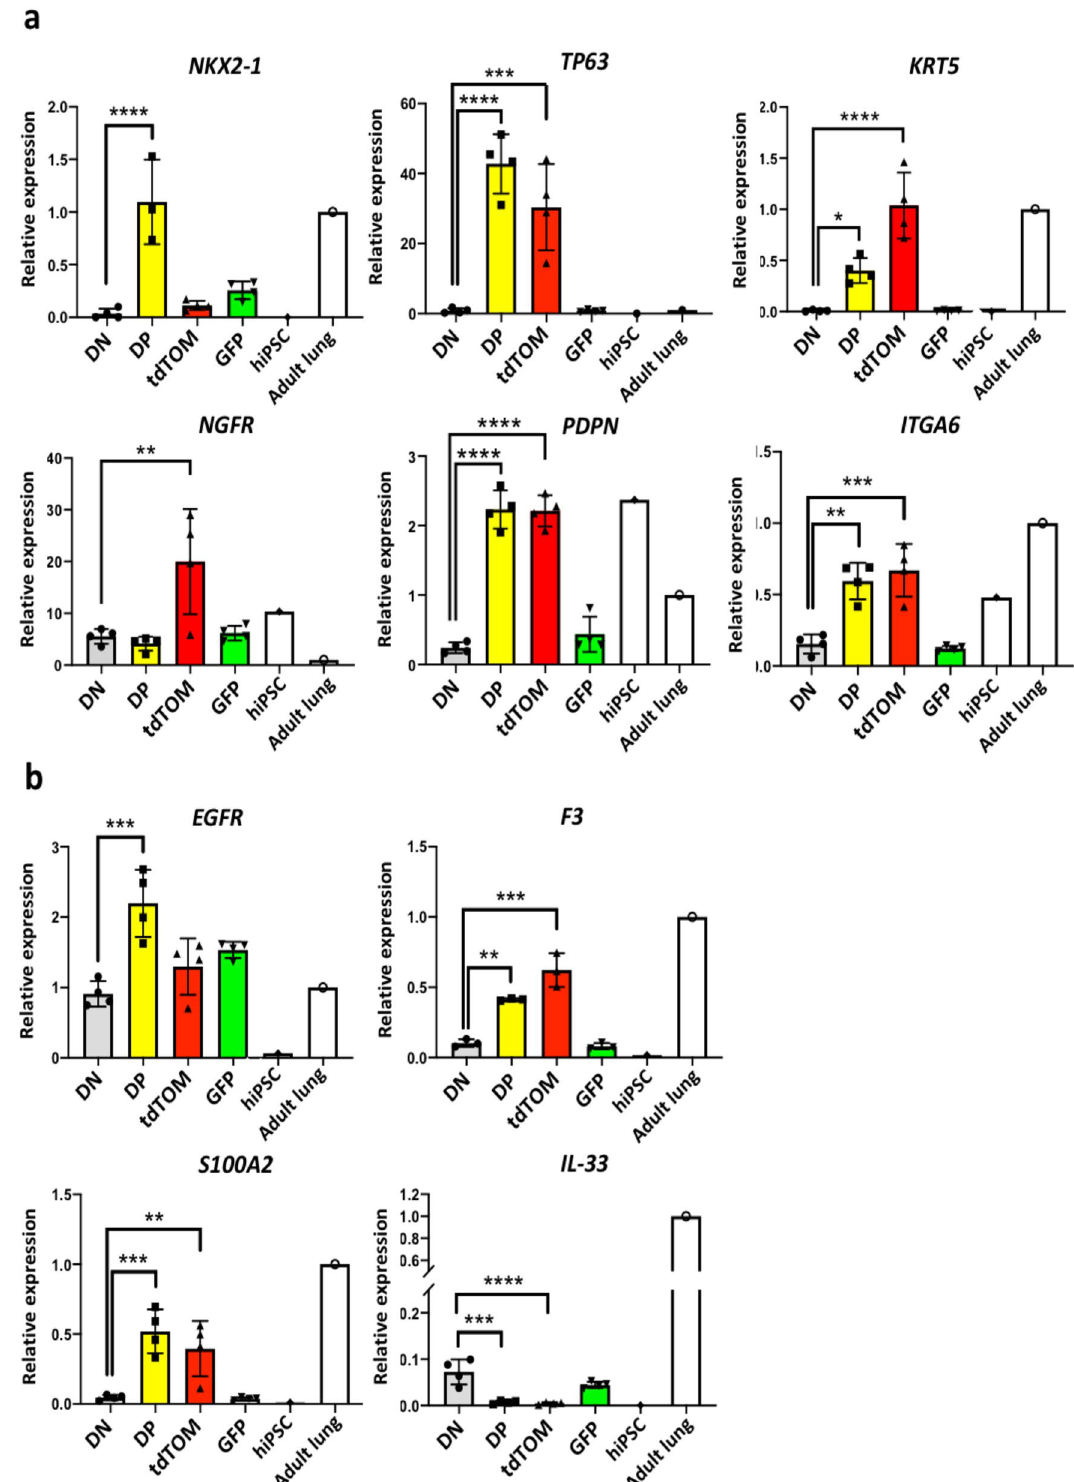
Figure 6. Analysis of basal cell marker expression in 4 cell fractions isolated from Day 30 proximalized lung organoids. ( a ) QPCR analysis of basal cell markers in DN, DP, tdTomato + and GFP + fractions isolated from Day 30 proximalized lung organoids. Expression levels were normalized to ACTB . DN double negative (GFP- tdTOM-), DP double positive (GFP + tdTOM +), tdTomato + tdTomato-positive only (GFP- tdTOM +), GFP GFP-positive only (GFP + tdTomato-), hiPSC undifferentiated BU3 NKX2-1 GFP hiPSCs. n = 4. **p < 0.01, ***p < 0.001, ****p < 0.0001. ANOVA followed by Tukey’s posthoc test. ( b ) QPCR analysis of other basal cell markers EGFR , F3 , S100A2 and IL-33 in the DN, DP, tdTomato + and GFP + fractions. Expression levels were normalized to ACTB . n = 4. **p < 0.01, ***p < 0.001, ****p < 0.0001. ANOVA followed by Tukey’s post hoc test. All graphs were made and statistical analyses were done using GraphPad Prism 8.0 (GraphPad Software Inc., San Diego, CA, USA) (www.graph